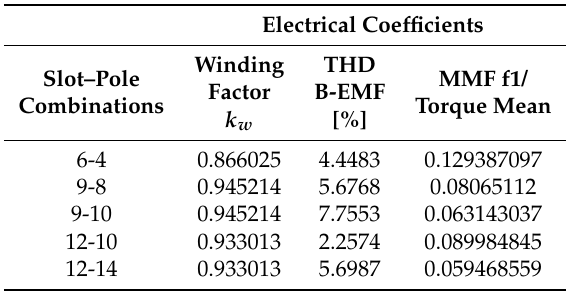
Table 7. Performance of healthy DL slot–pole combinations, Part II.